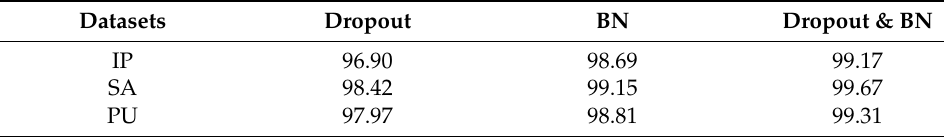
Table 4. OA accuracy of SSCRN with different regularizers.